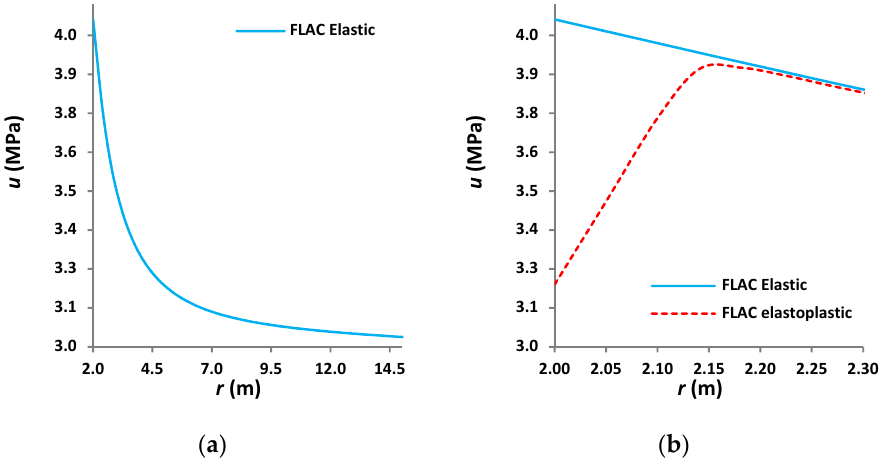
Figure 9. Numerical simulations of the undrained condition carried out with FLAC at ϑ = 0° The initial pore pressure is u ini = 3 MPa ( a ) Trend of the pore pressure in the elastic field versus radial distance r . ( b ) Comparison between the pore pressures calculated in the elastic and elastoplastic field.